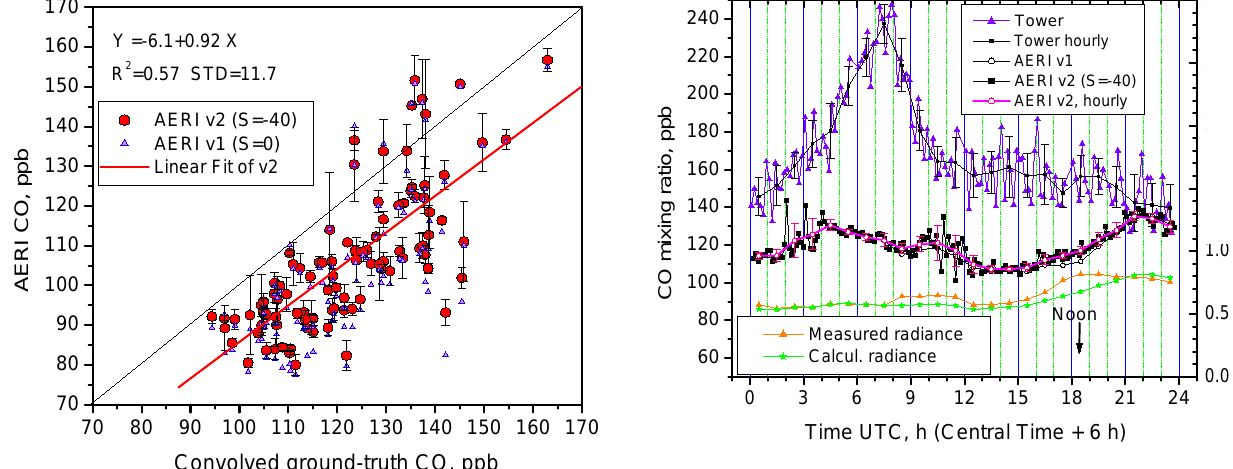
Fig. 8. Comparison of v1 and v2 CO mixing ratios retrieved from the AERI spectra with convolved composite ground-truth profiles (see Fig. 2). Vertical bars are STD variations of AERI retrievals for the 1-hour-long interval corresponding to the aircraft profile. The red line is the linear fit for AERI v2.